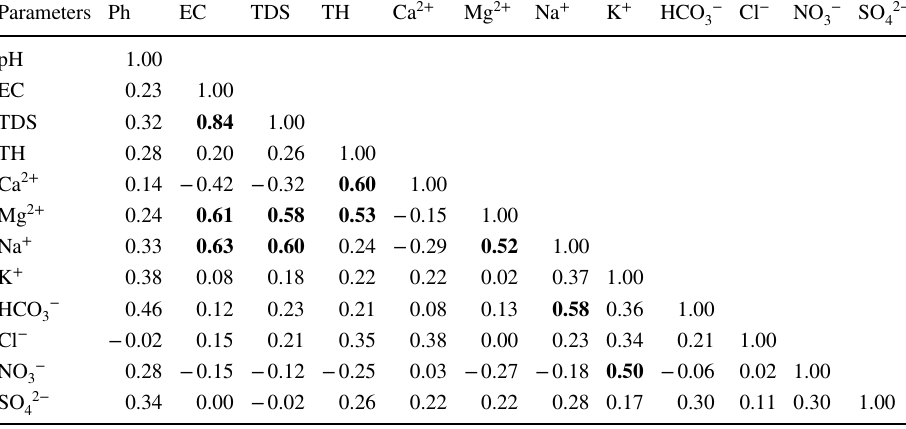
Table 6 Correlation matrix for groundwater samples (pre- monsoon)